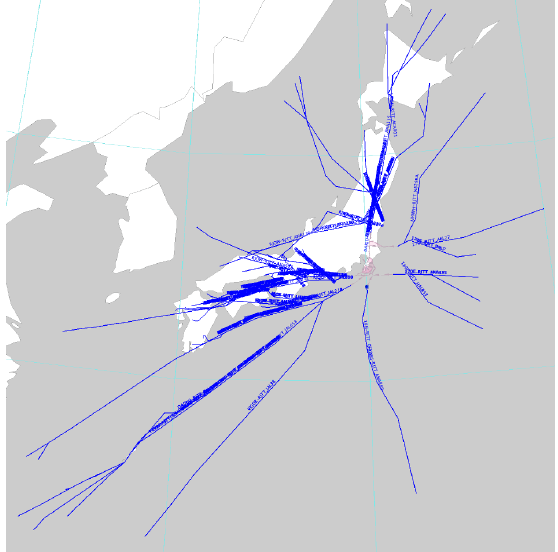
Figure 12. Flight paths of arrivals at RJTT in a day ( blue lines ), excluding standard terminal arrival routes (STARs) and standard instrumental departures (SIDs).